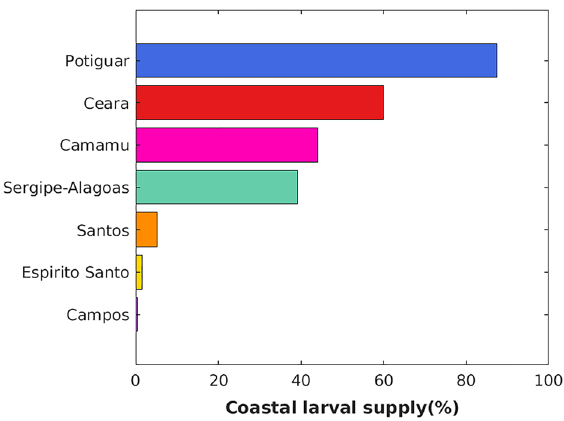
Figure 7. Effectiveness of the Brazilian oil-producing basins in supplying the coastline with sun-coral larvae as the percentage of total living particles released in each basin reaching the coast computed from all simulations. Created with Matlab R2018a (http:// www. mathw orks.